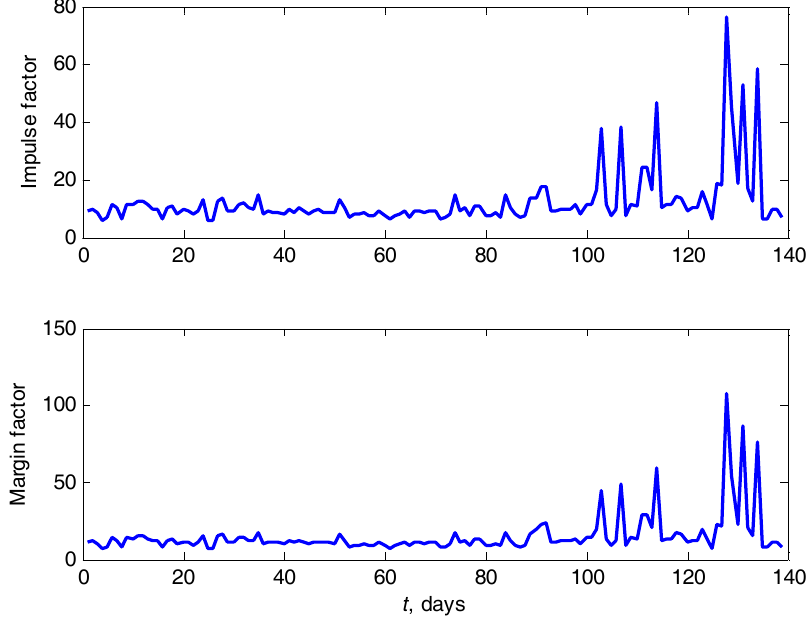
Figure 5. Impulse factor (IF) and margin factor (MF) feature calculated from the vibration slew bearing signal.